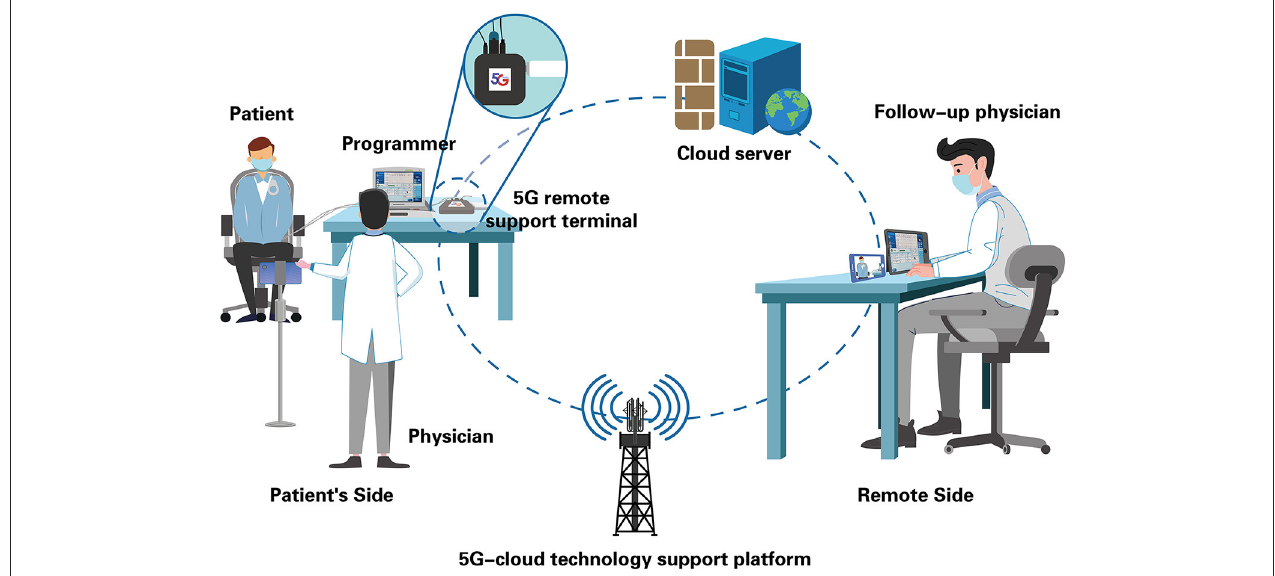
FIGURE 1 | Schematic representation of real-time remote programming for cardiovascular implantable electronic devices (CIED) follow-up through the 5G cloud technology support platform (5G-CTP). The patient’s side is equipped with a CIED programmer, a 5G remote support terminal, and a physician; the remote’s side is equipped with a tablet installed with a cloud follow-up APP, as well as a follow-up physician (clinical device specialist). The physician initials the cloud follow-up by externally connecting the 5G remote support terminal to the programmer, and putting the wand to the patient’s device. When confirming the communication is stable, the physician gets in contact with the follow-up physician and gives a briefing. Follow-up physician logs into the cloud follow-up APP to establish a remote connection with the 5G remote support terminal on the patient’s side. Then he has complete control of the programmer, and is able to interrogate, test, and reprogram the device remotely as needed. The whole remote service system is deployed on the cloud server with multilayer protection, including firewalls, customized antivirus, and vulnerability scanning, along with intrusion